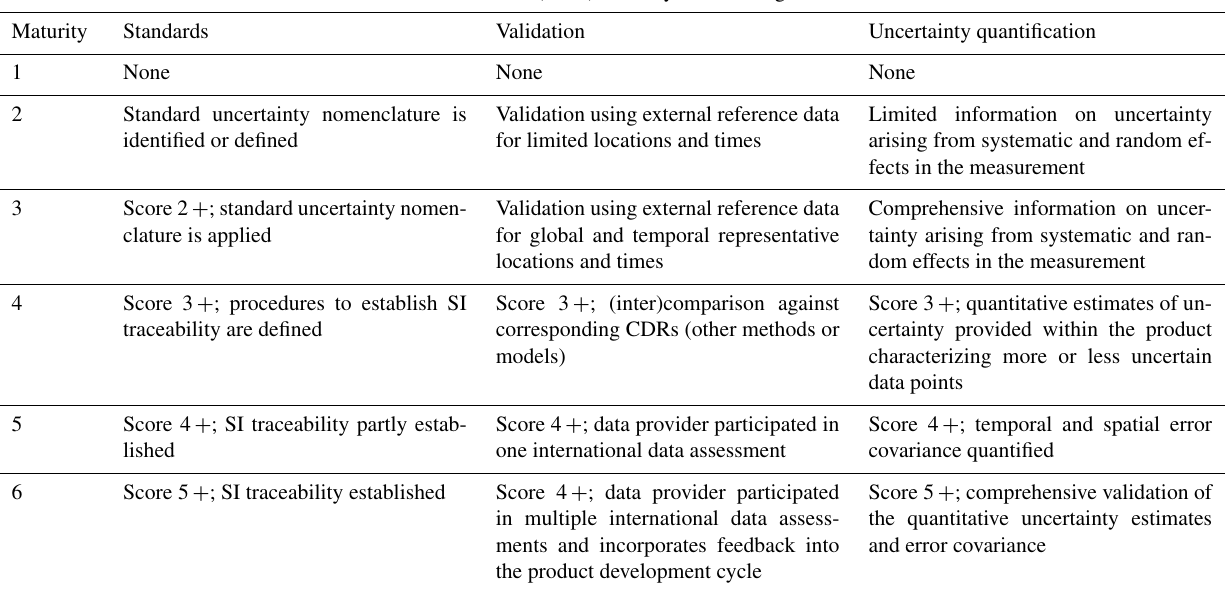
Table 3. Criteria for scoring the maturity of aspects of a CDR generation system, including criteria for uncertainty characterization, taken from the system maturity matrix of Schulz et al.